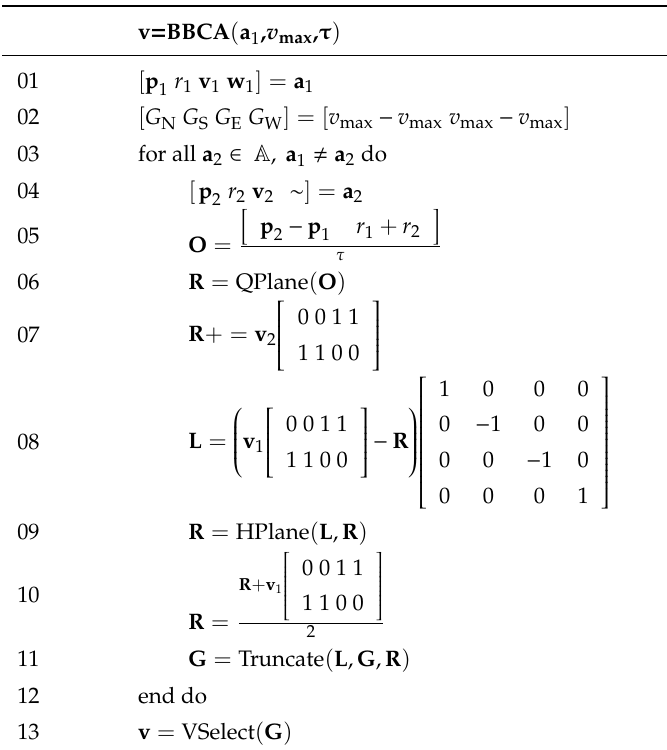
Table 2. Bounding box collision avoidance (BBCA) algorithm.